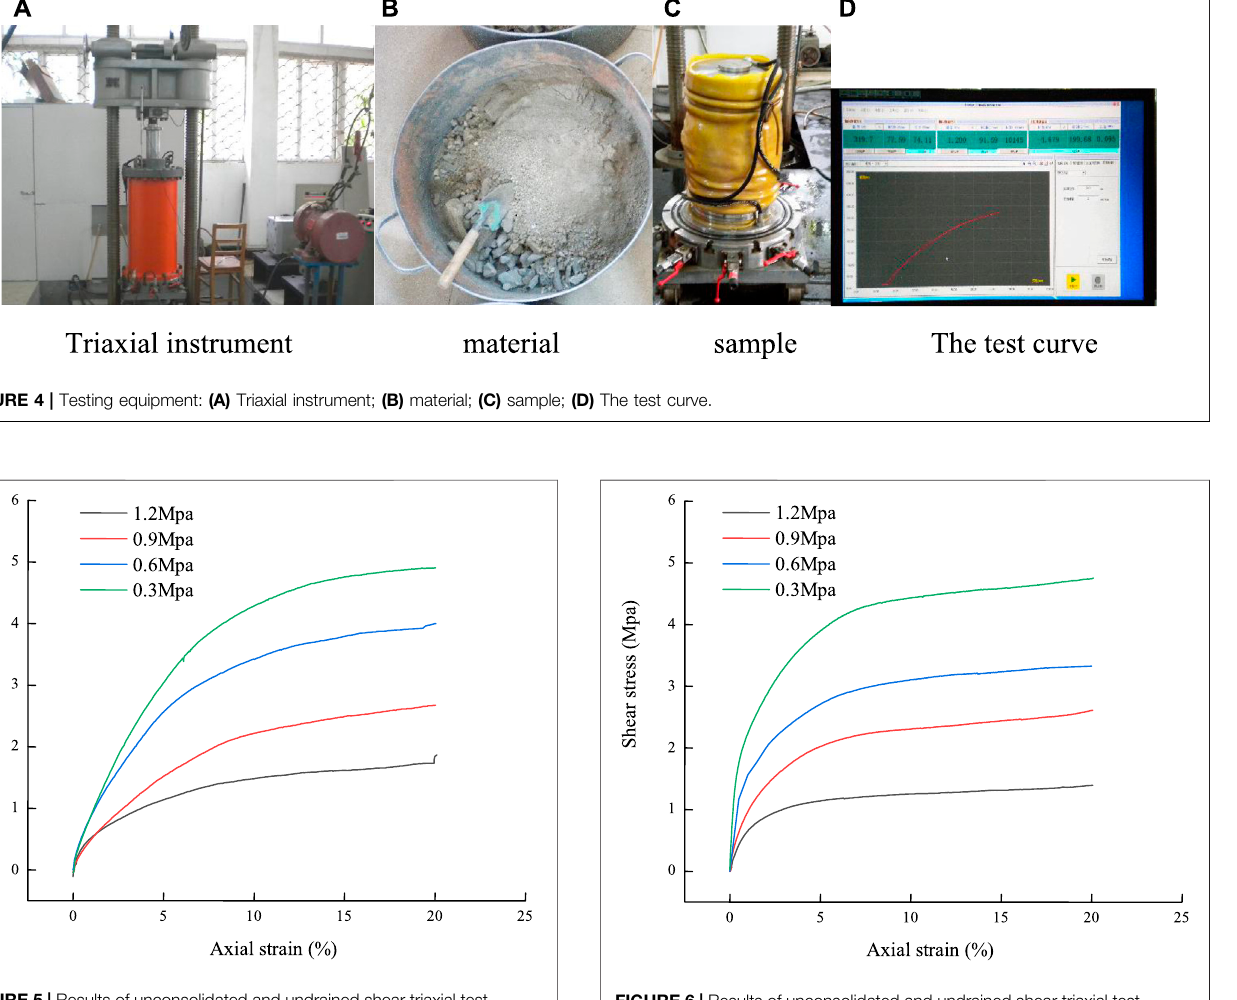
FIGURE 6 | Results of unconsolidated and undrained shear triaxial test of gravel slag and sand-soil mixture